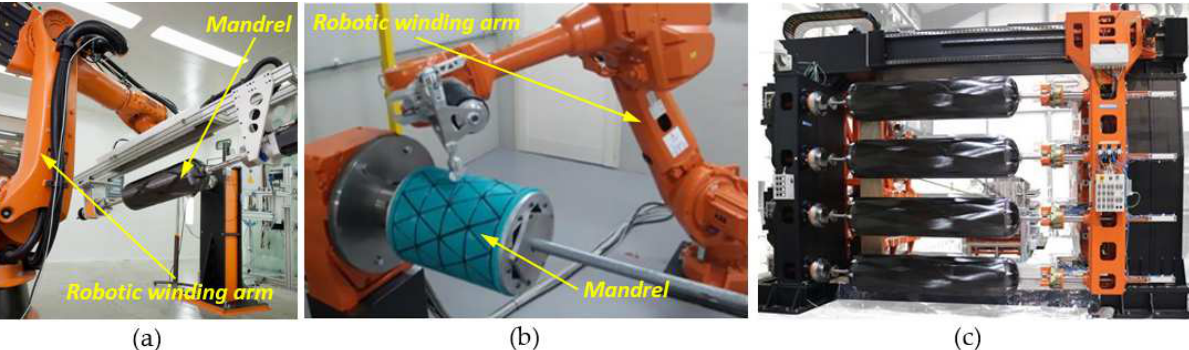
Figure 5. Arrangements of robot head installation: ( a ) fixed fiber guide/payout eye and flexible mandrel [119]; ( b ) flexible fiber guide/payout eye and fixed mandrel [118]; ( c ) Mikrosam’s automated production line for CNG and hydrogen tanks [120]. Reproduced with permission from Mikrosam.